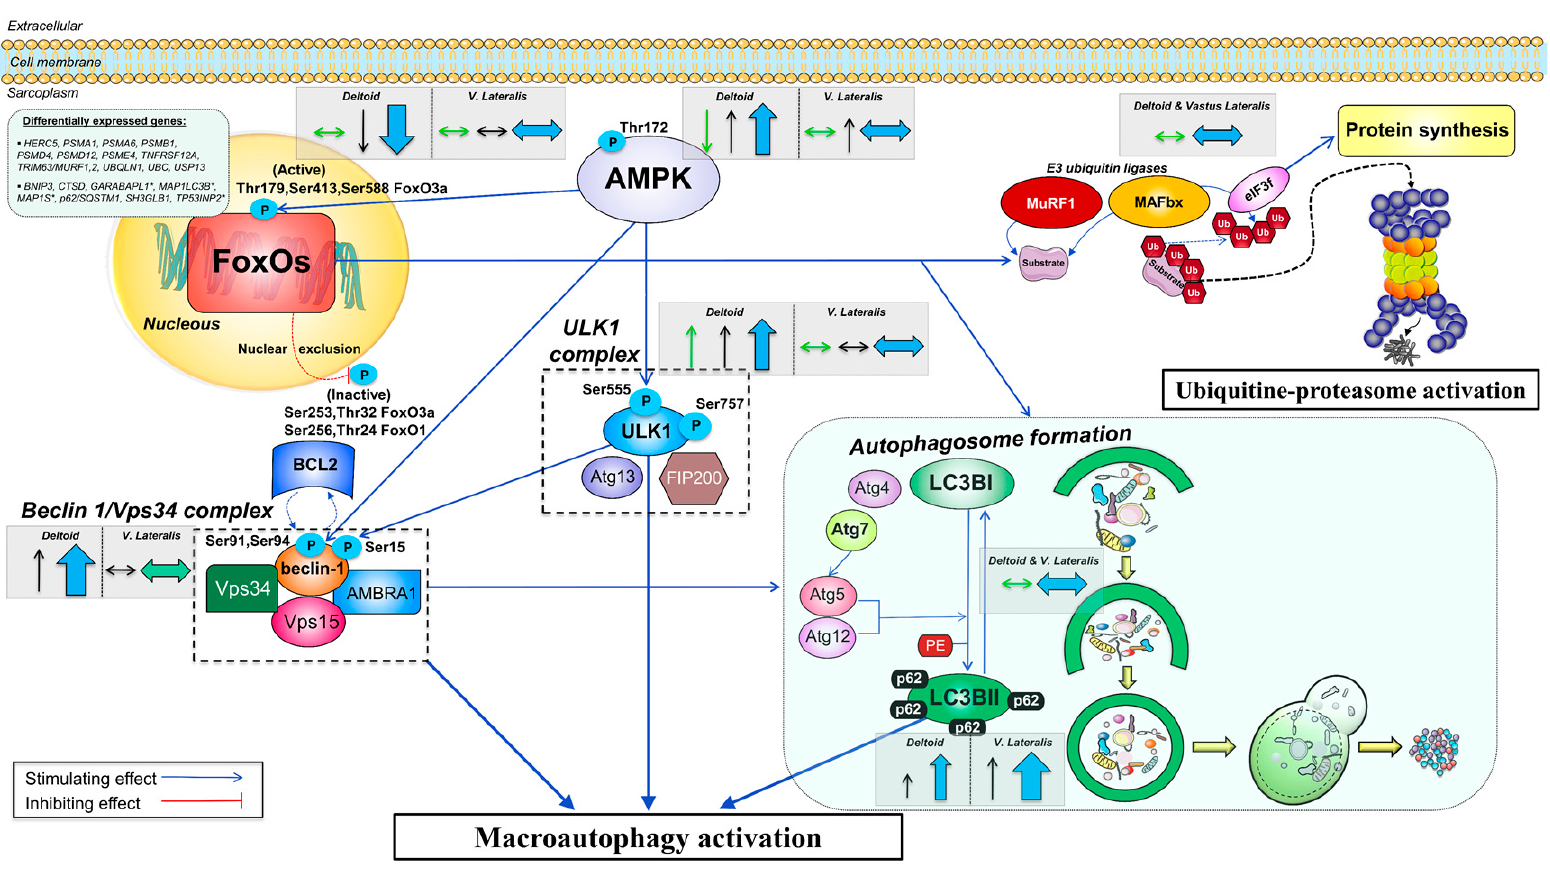
Figure 6. Schematic representation of the regulation of the autophagy-lysosome system in response to severe energy deficit and its modulation by exercise. An upregulation of numerous genes involved in the ubiquitin-proteasome and the autophagy-lysosome degradation pathways is seen after the CRE phase, primarily in the vastus lateralis. Elevated levels of cortisol with low insulin, testosterone, and leptin levels did not prevent increased inhibitory phosphorylation of FoxO1 and FoxO3a in the deltoid muscles, which was blunted by prolonged low-intensity exercise in the vastus lateralis, despite inactivation of the PI3K/Akt/mTOR pathway [52]. FoxOs orchestrate the activation of the ubiquitin-